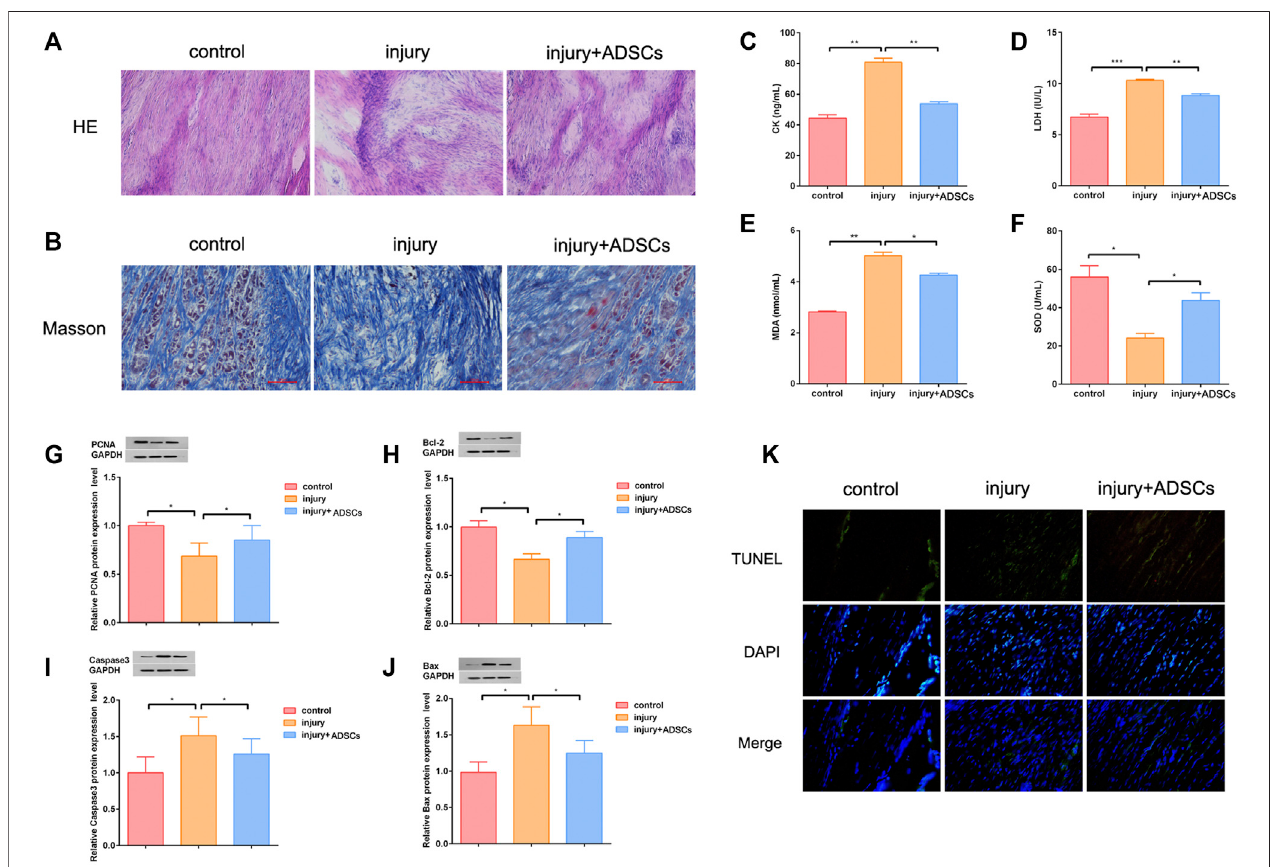
FIGURE5| ADSCspromotedtendonwoundhealing invivo . (A) HEstainingwasusedtoobservetendontissue;Basemagni fi cation:×200 (B) Massonstainingwas used to observe tendon tissue; Scale:100 μ m (C – F) ELISA assay was performed to detect the level of CK, LDH, MDA and SOD. The oxidative stress level of injured tendon was reduced after ADSCs treatment (G – J) Western blot was used to detect the expression of PCNA, Bcl-2, Caspase3 and Bax of injured tendon after ADSCs treatment (K) TUNEL assay showed that the level of apoptosis in tendon tissue was decreased after ADSCs treatment. The blue is the nucleus. the above green fl uorescence intensity was positively correlated with the level of apoptosis; Under the merged image; Base magni fi cation:×200 ( n = 3; Mean ± SD, * p < 0.05, ** p < 0.01, *** p < 0.001; Student ’ s t-tests).